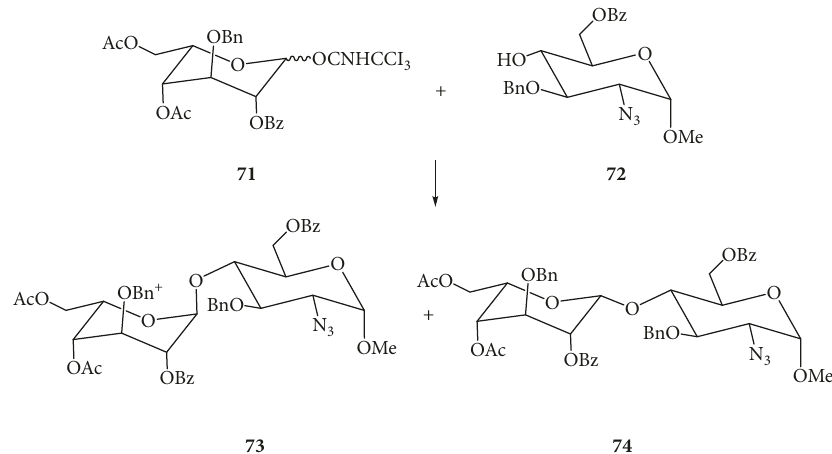
Scheme 22: Synthesis of the BA disaccharide fragment through the